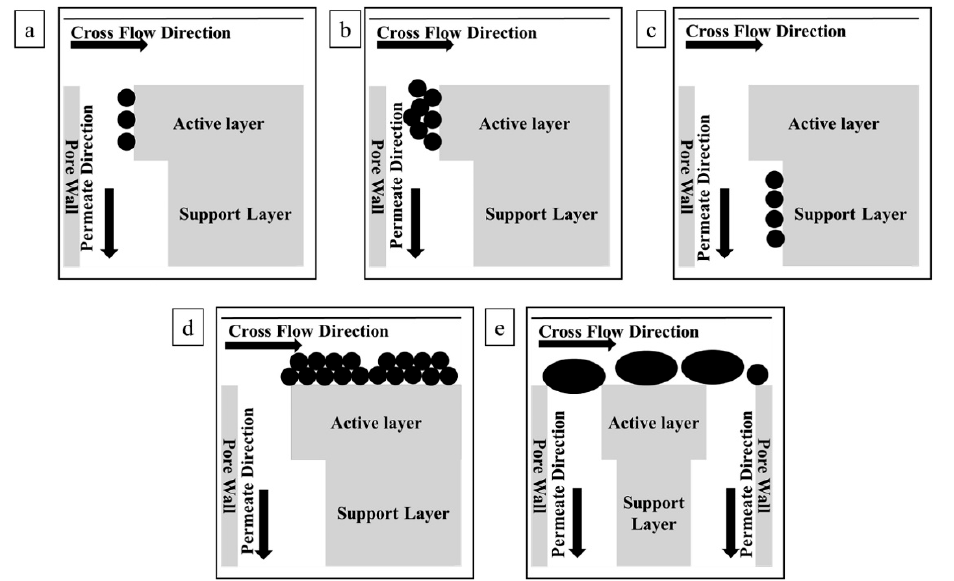
Figure 3. Schematic diagrams of various fouling mechanisms: ( a ) monolayer adsorption; ( b ) pore constriction at the active layer; ( c ) monolayer adsorption at the support layer; ( d ) outer surface fouling; ( e ) intermediate pore blockage [71].